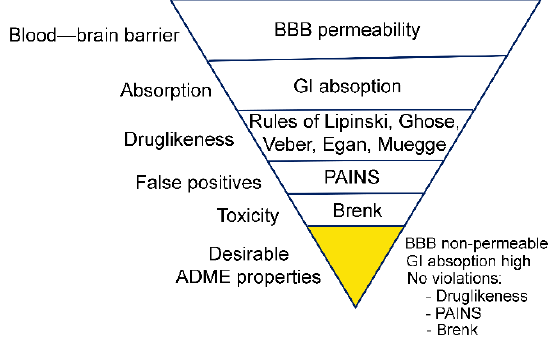
Figure 4. Ligand selection, based on ADME filtering.